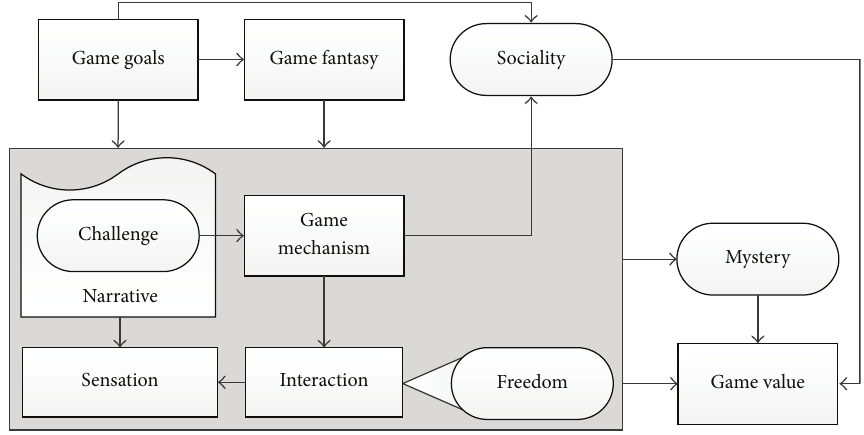
Figure 3: GBL design